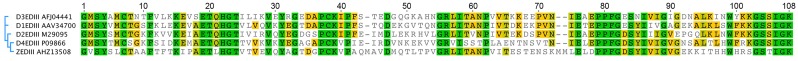
Similarity of domain III of the envelope protein (EDIII).EDIII sequences are aligned. Green: 100% similar; khaki: 80 to 100% similar; orange: 60 to 80% similar; grey: less than 60% similar. Numbering is relative to that of ZEDIII.